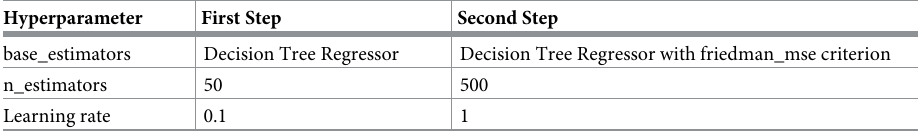
Table 5. Hyperparameters used by the adaboost model.